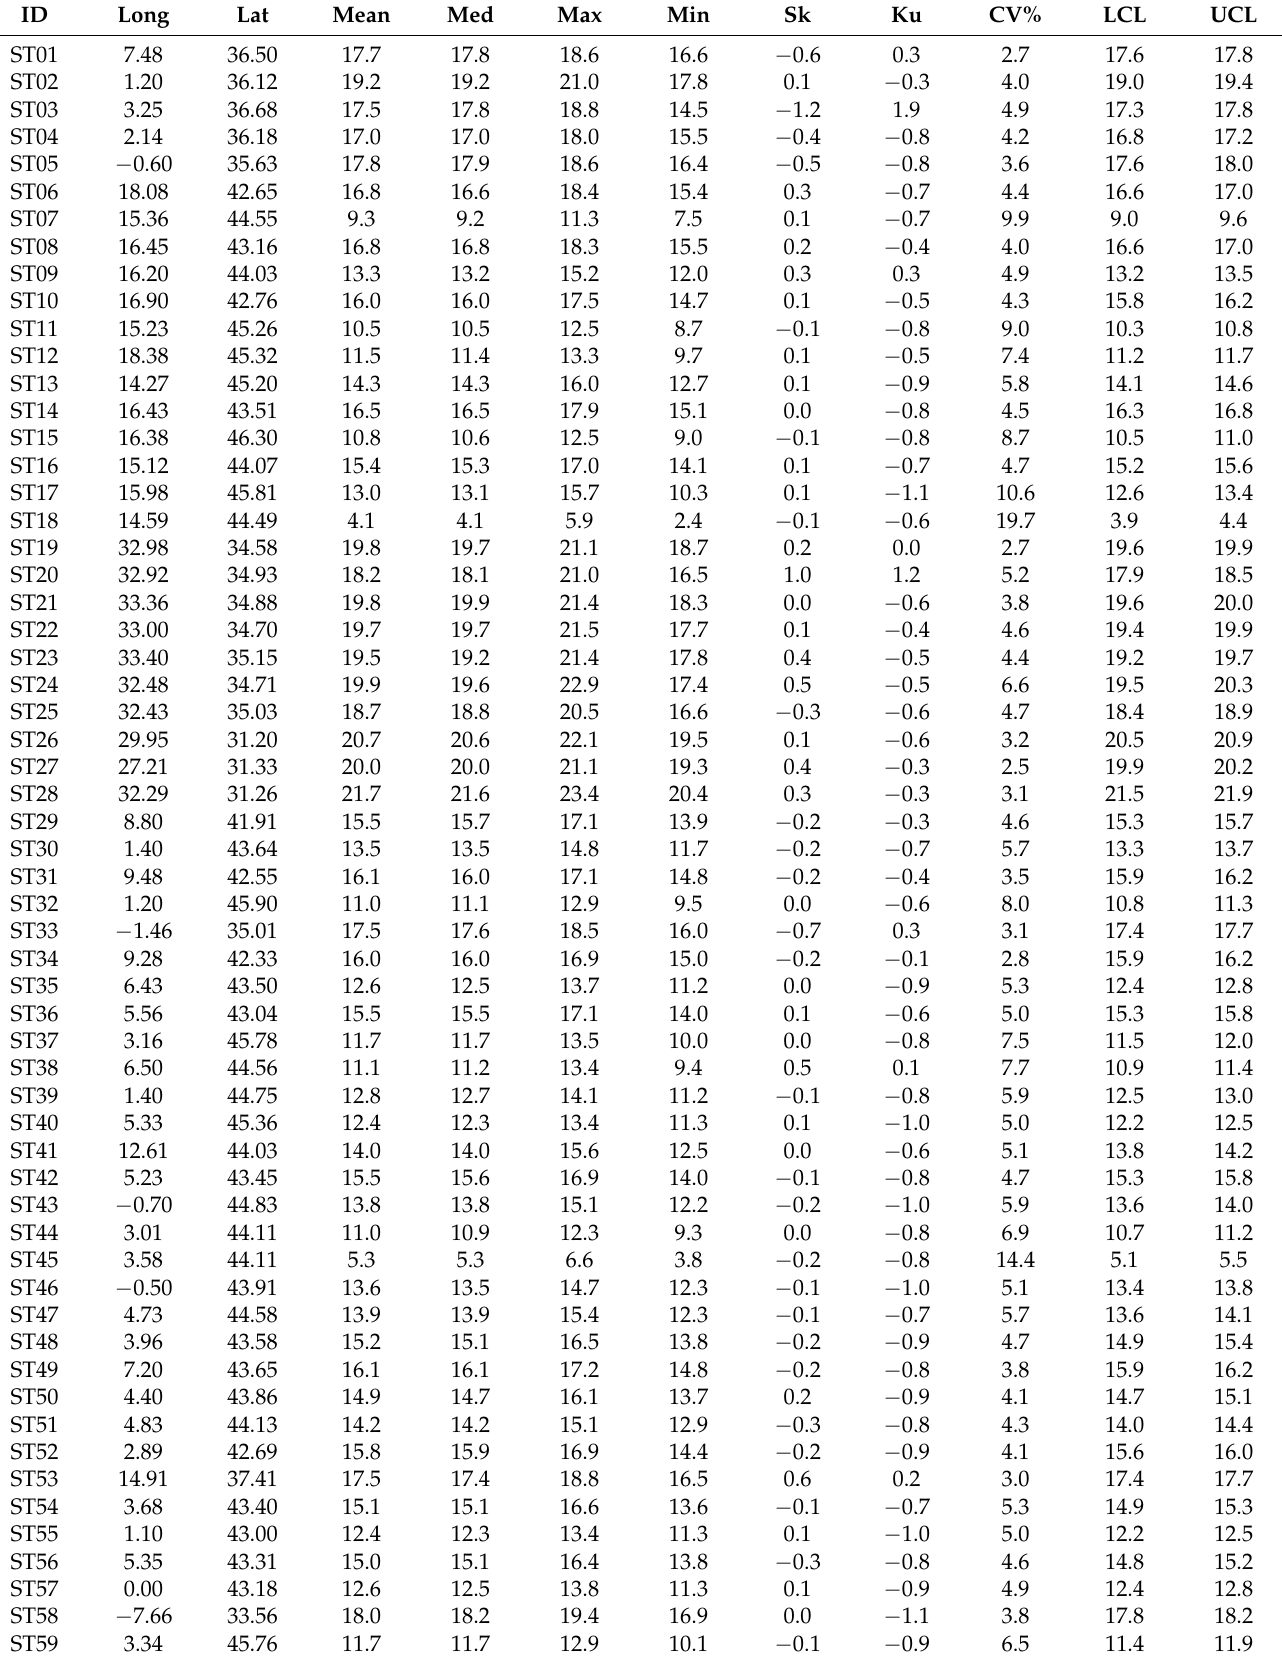
Table A2. Main statistical characteristics of mean annual temperature over the MED during